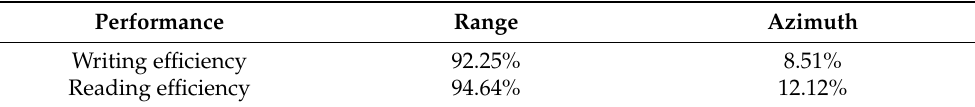
Table 1. Performance of the conventional synthetic aperture radar (SAR) data storage method.